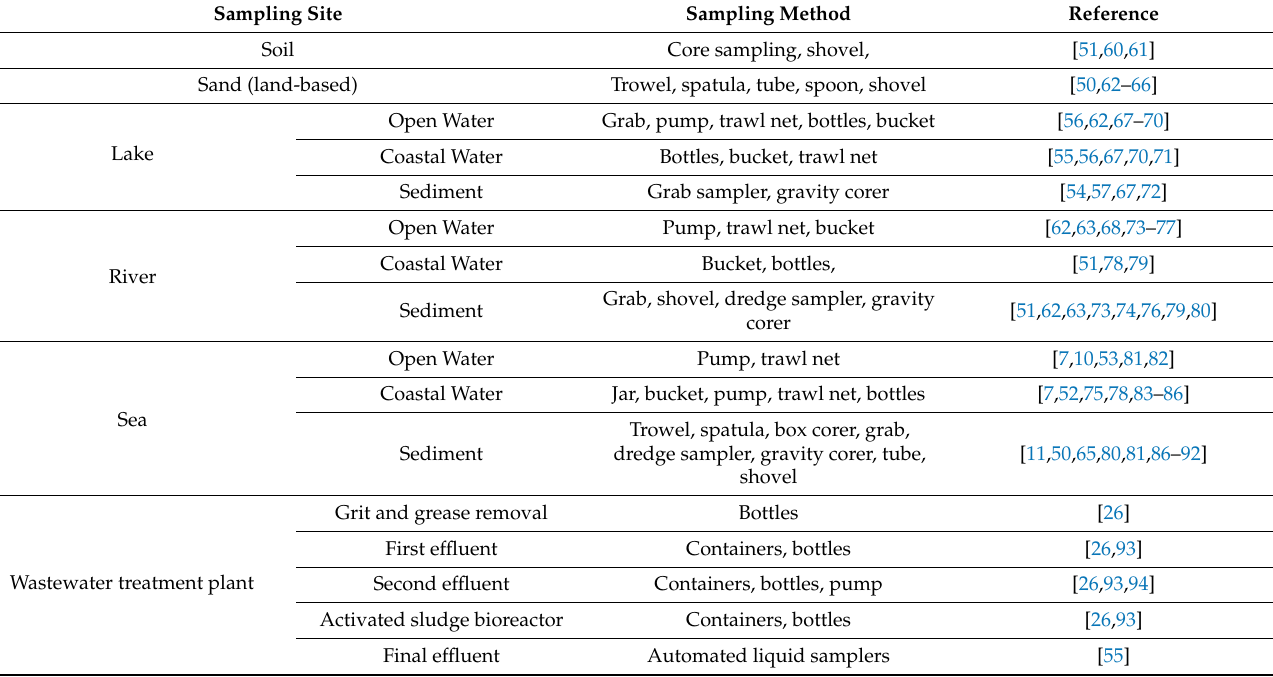
Table 1. Sampling media and